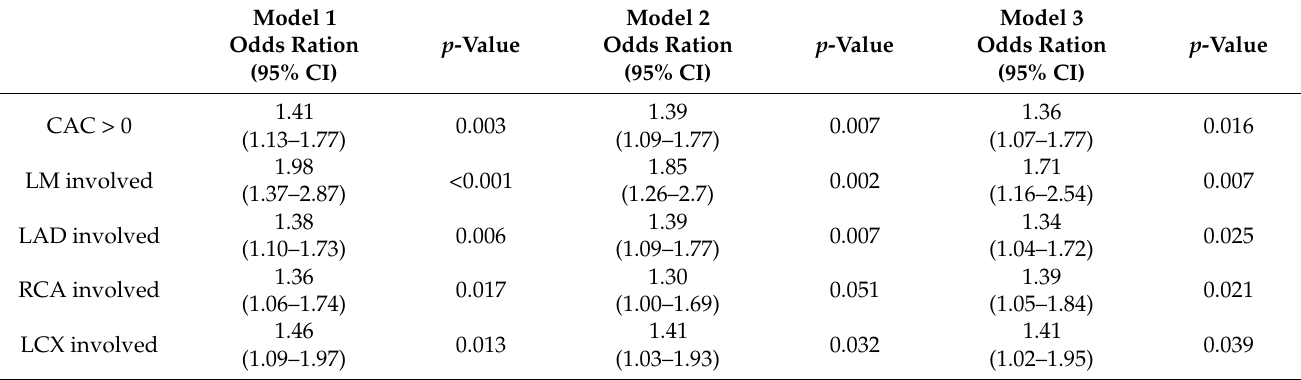
Table 3. Multivariate analysis for different NAFLD with CAC > 0 and separated calcified coronary artery